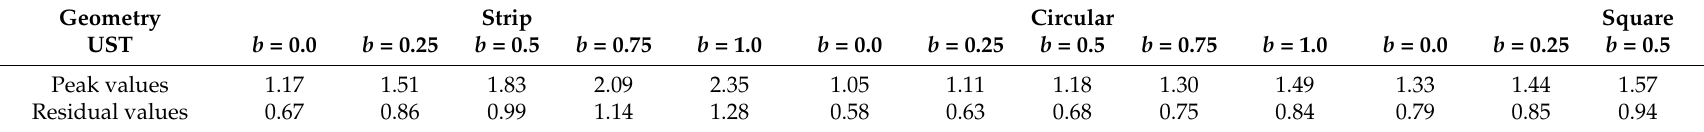
Table 3. Peak and residual values of bearing capacity factor N γ yield by FLAC and